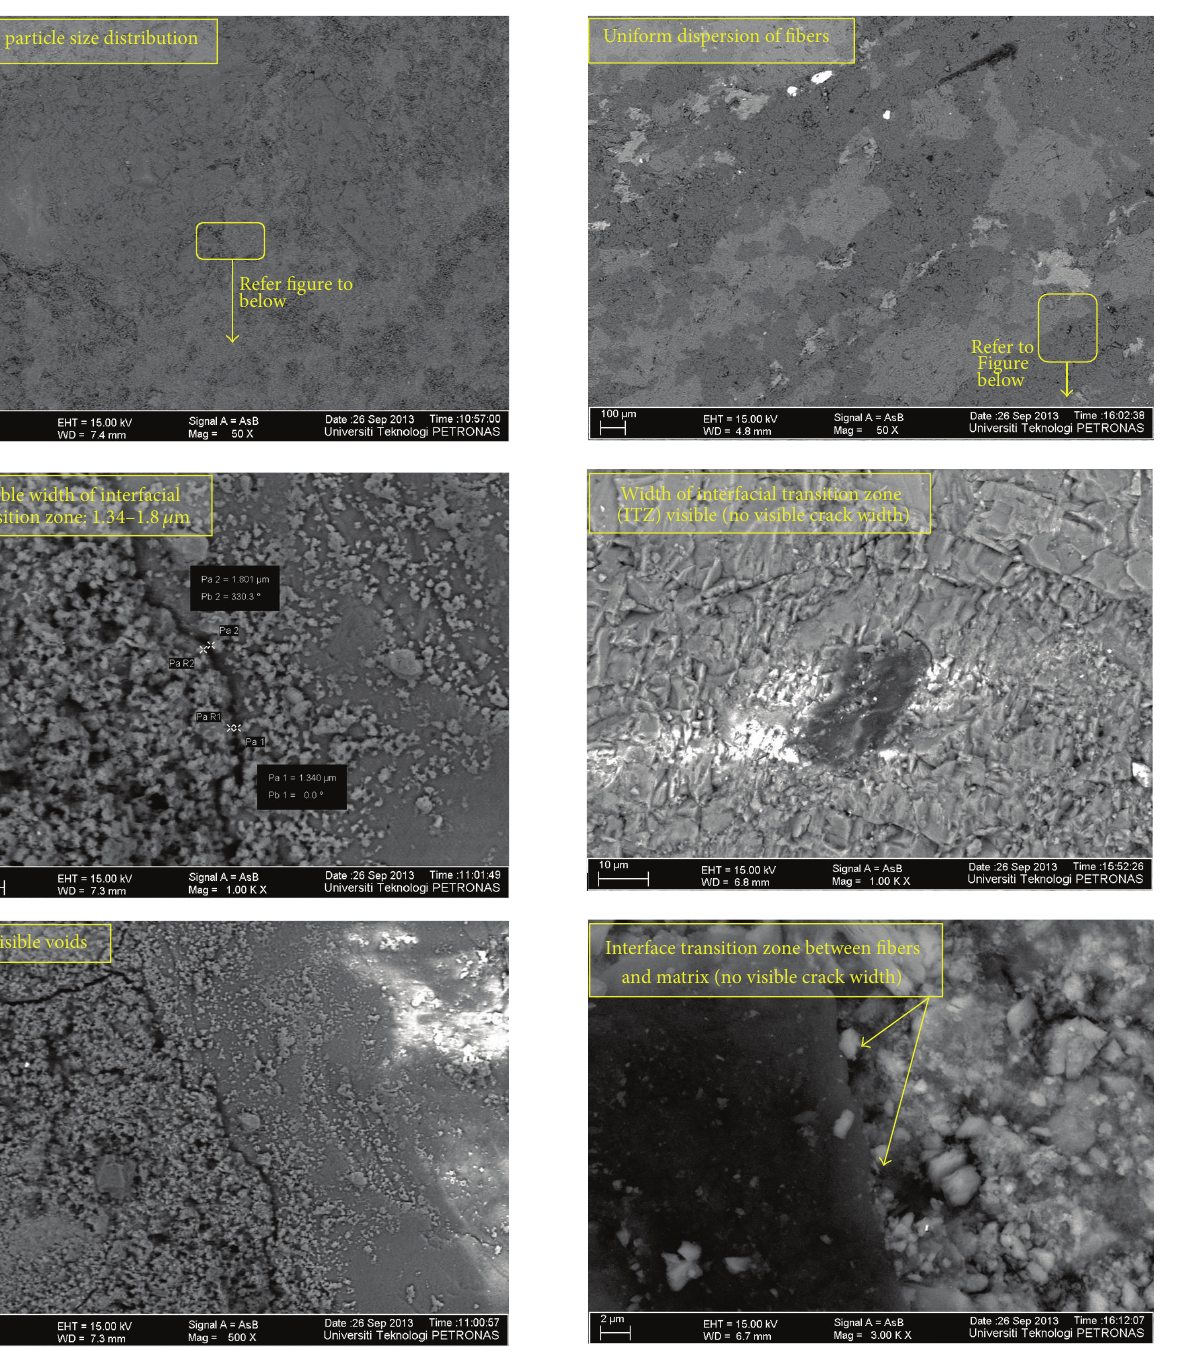
Figure 13: Microstructure of concrete mix “M-0.”